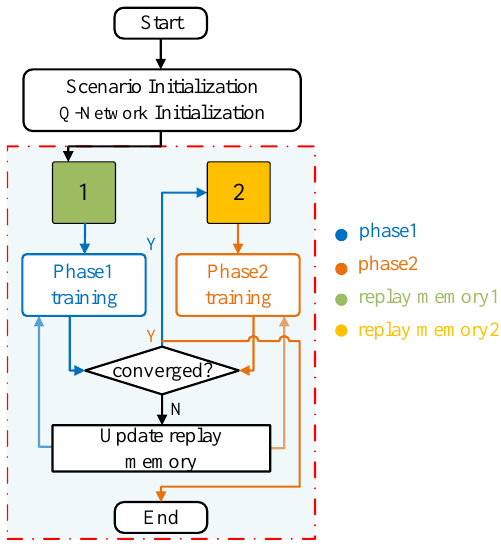
Figure 5. Flow diagram of the MS-DDQN training process.